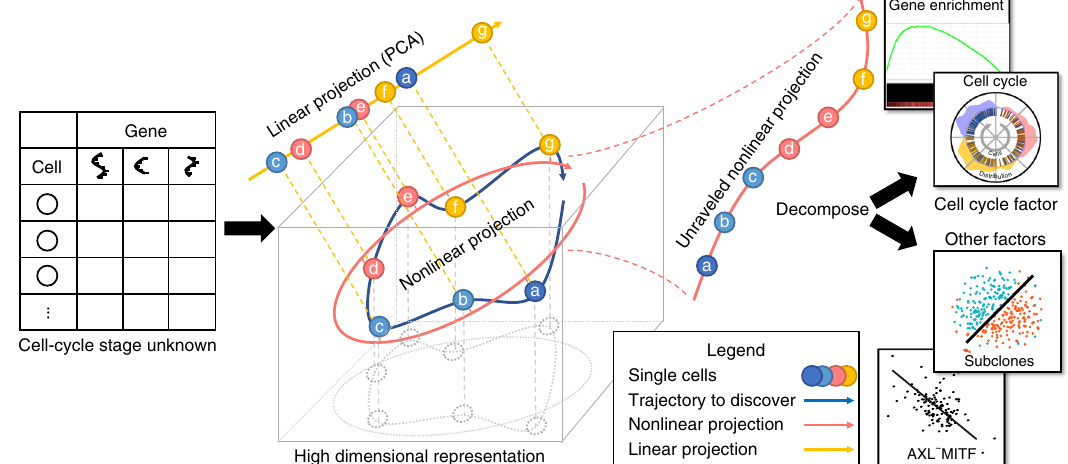
Fig. 1 Overview of the Cyclum program. Single-cell RNA-seq data in the format of a cell-gene expression matrix are given to Cyclum, which identi fi es a circular trajectory consisting of cells at different times (indicated by letters) and stages (labeled by colors) in the high-dimensional gene expression space (illustrated by a cube). Cyclum unravels the circular trajectory (red arrows) along with the projected cells to infer their pseudo-time. In contrast, a linear projection (yellow arrow) would result in incorrect ordering and timing. The inferred genes and pseudo-times can be further analyzed to discover new functions, cell-types, and cell-phenotype associations.